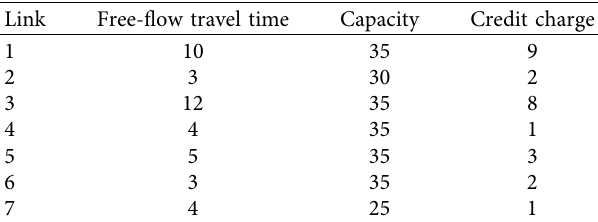
Figure 1: The toy network. Table 1: Input data of the small